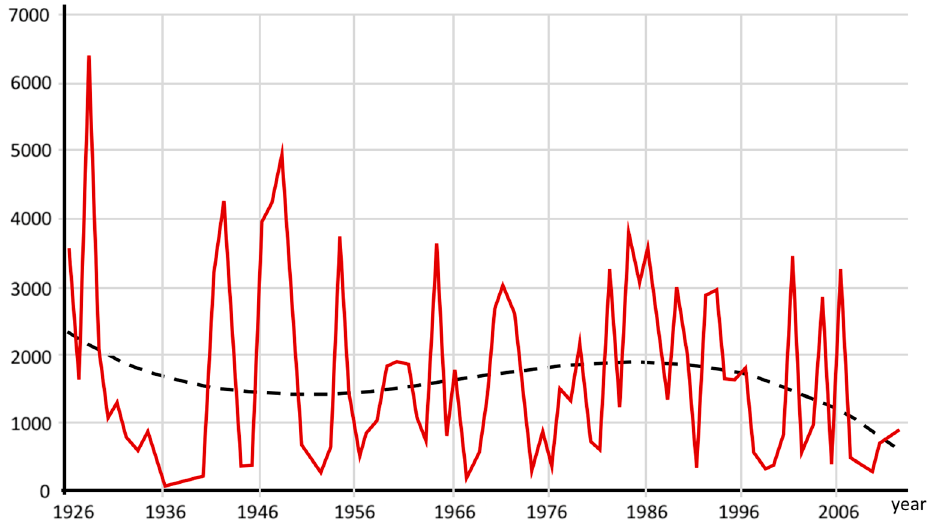
Figure 3. Annual runoff of the Ishim River within Northern Kazakhstan (Mm 3 ).